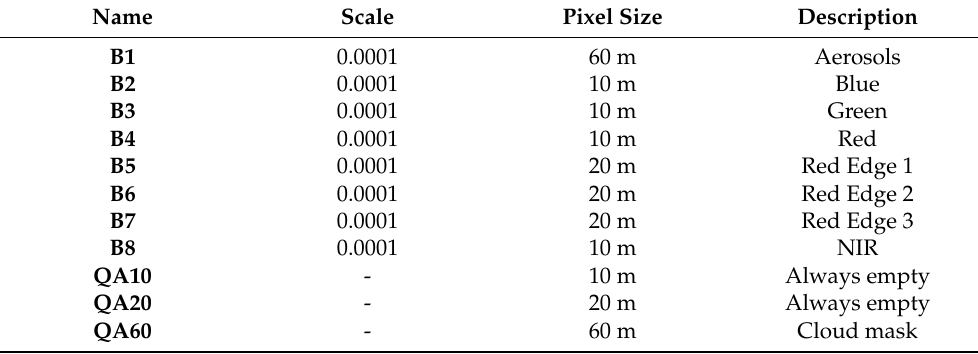
QA20 - 20 m Always empty QA60 - 60 m Cloud